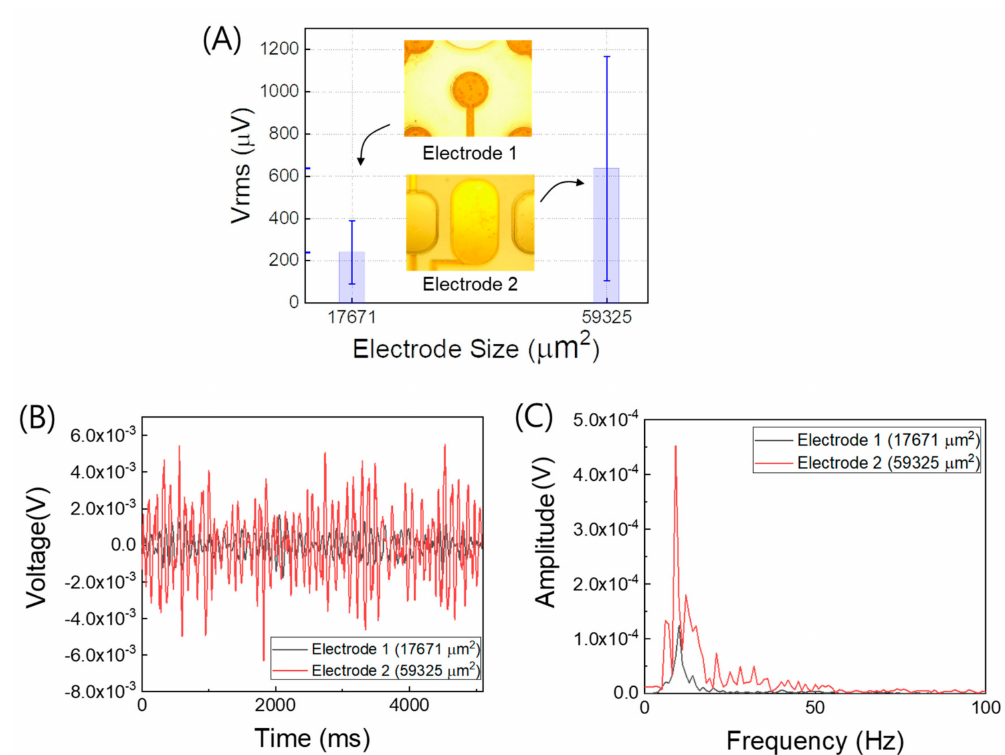
Figure 4. Comparison of the recorded sEMGs for di ff erent electrode sizes. ( A ) Averaged V rms (root-mean-square voltage) of the recorded sEMG with Electrode 1 and Electrode 2. ( B ) Comparison between the best channel of each microelectrode array. ( C ) Averaged fast Fourier transform (FFT) data of Electrodes 1 and